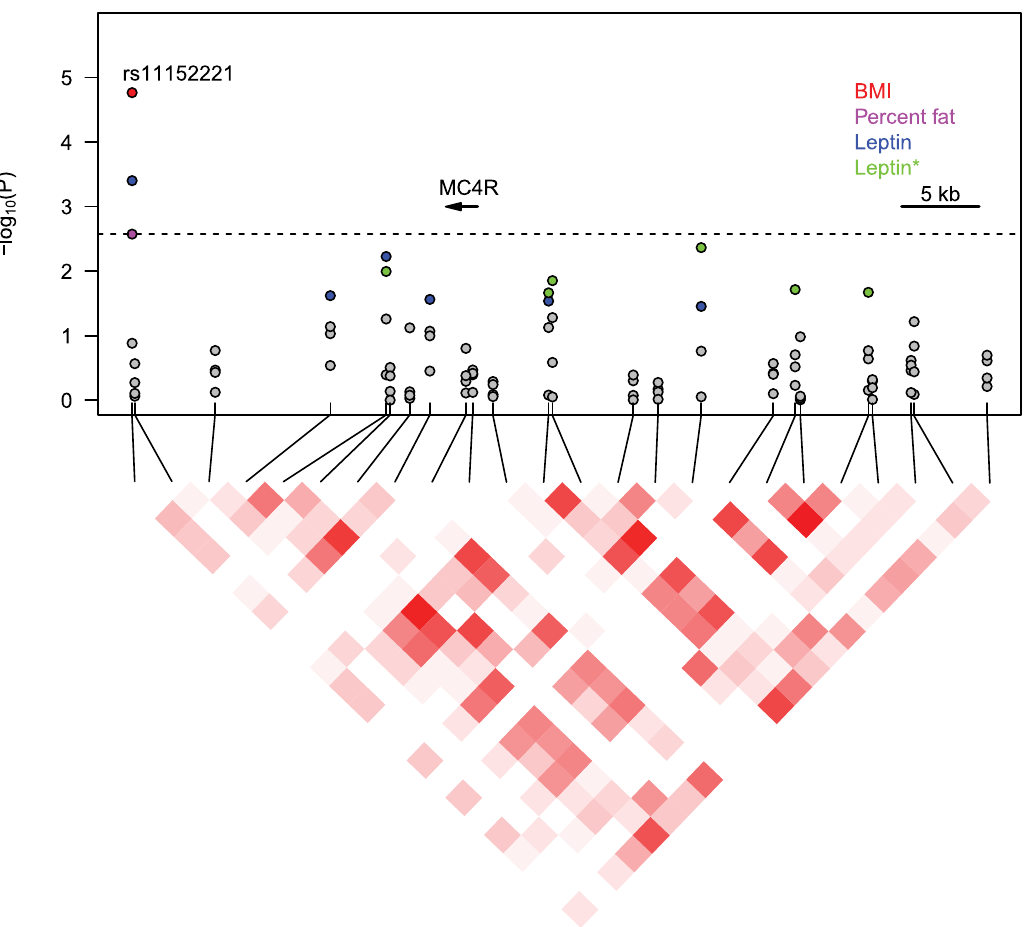
Figure 1. SNP associations in and near MC4R with adiposity in white Health ABC participants. SNP genotypes from custom Illumina Golden Gate array. Gray points indicate association P -value . 0.05. Non-gray points indicate significant ( P -value # 0.05) associations with an adiposity trait of the corresponding color in the legend. Leptin* indicates association P -value for leptin adjusted for percent body fat. Dashed line indicates cut- off value for empirical P -value # 0.05. LD heatmap indicates higher r 2 measures with darker red